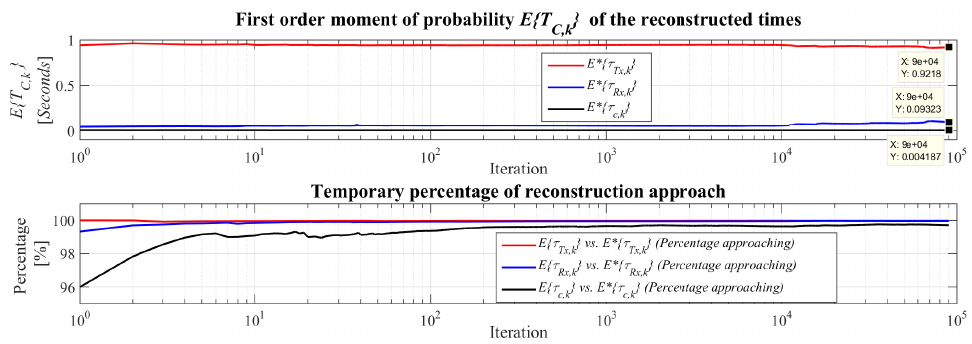
Figure 16. First order moment of probability E { T C , k } of communication times (using log scale on x -axis).